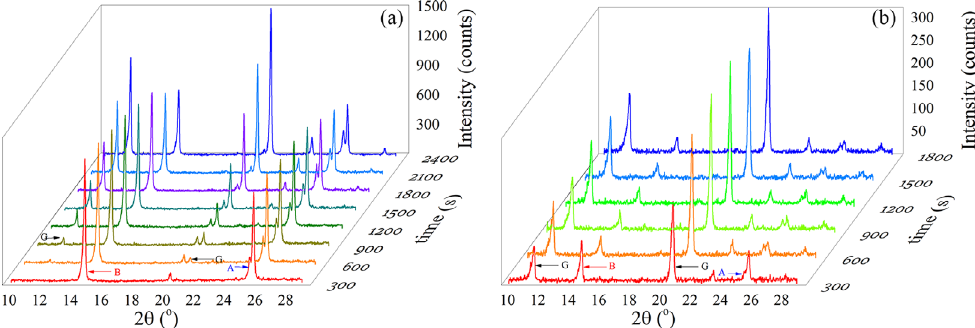
Figure 10. In-situ XRPD patterns of the hydration of samples (a) CP1 and (b) RP1. We highlight the main peaks of the anhydrite (A) bassanite (B) and gypsum (G) phases.